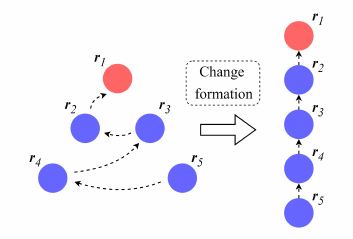
Figure 5. Changing formation